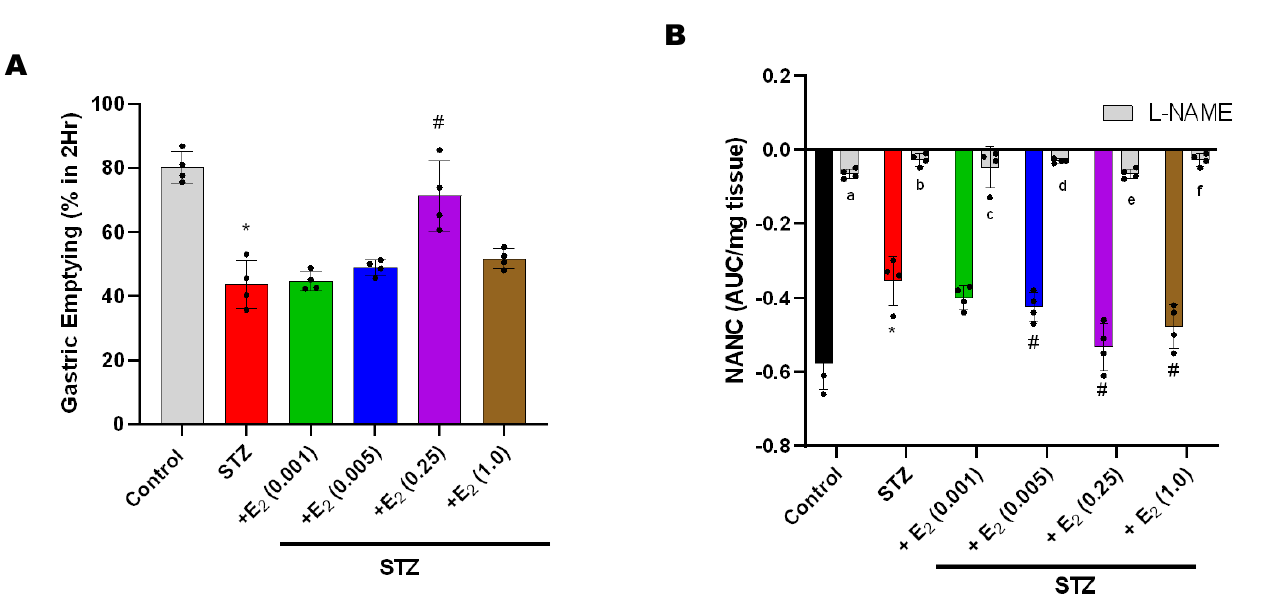
Figure 1. Effect of 17 β -estradiol (E 2 ) on solid gastric emptying and gastric antral nitrergic relax- ation in STZ-induced diabetic female mice. The rate of GE was measured as follows: 1 − [(Gastric Content/Food Intake) × 100 ( A ). Full and empty stomach weights were recorded to estimate the remaining gastric content after a 2 h fast. Nitrergic relaxation was measured in gastric antral cir- cular muscle strips at 2 Hz in an organ bath under physiological conditions ( B ). Nitric oxide (NO) dependence of NANC relaxation was confirmed by pre-incubation (30 min) with NO inhibitor nitro-L-arginine methyl ester (L-NAME; 100 µ M). Area under the curve (AUC) per mg of tissue is pre- sented. Data were analyzed with one-way ANOVA using GraphPad Prism. Data are means ± SEM ( n = 6). * denotes p < 0.05; significantly different from healthy mice (Con). # denotes p < 0.05; signifi- cantly different from STZ-induced diabetic mice (STZ). a denotes p < 0.05 to control with L-NAME, b,c,d,e,f denotes p < 0.05 to respective groups with L-NAME. Legends: gastric emptying (GE), non- adrenergic, noncholinergic (NANC), nitric oxide (NO), nitro-L-arginine methyl ester (L-NAME), area under curve (AUC), analysis of variance (ANOVA), standard error of the mean (SEM), streptozotocin